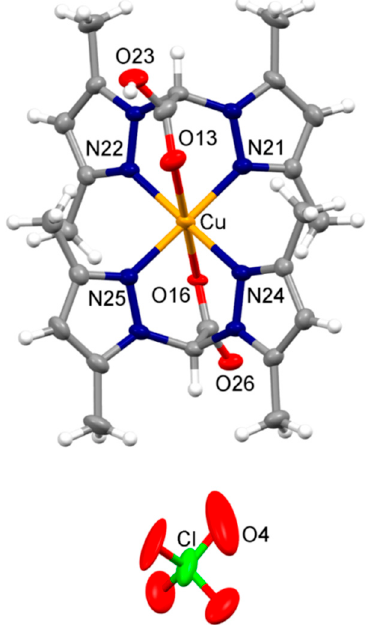
Figure 3. Molecular structure of ( 1 ) with thermal ellipsoids drawn at the 30% probability level. Disordered molecular fragments were removed for clarity.